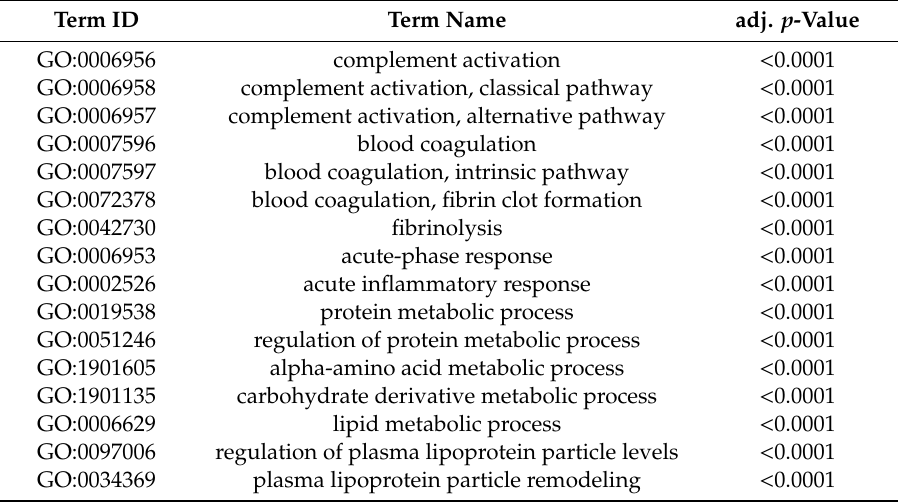
Table 1. Pathway enrichment of PHH secretome.